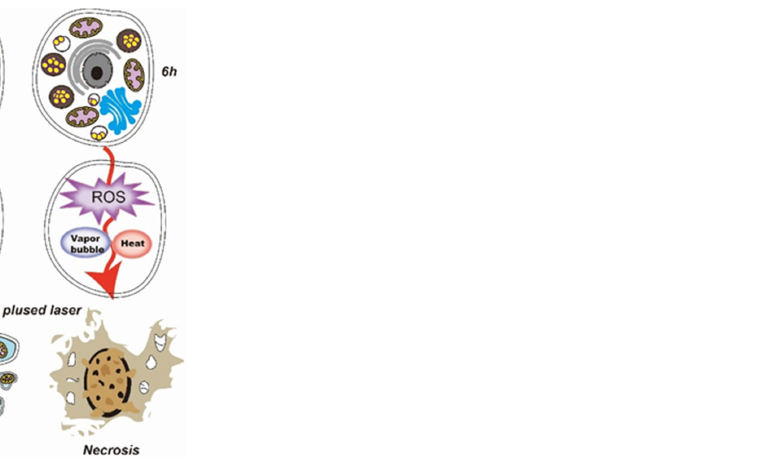
Figure 1. The effect of PEG-coated gold nanospheres (PEG-AuS) for phototherapy under nanosecond pulsed laser radiation. 2. Material and Methods 2.1. Cell Lines and Reagents The human moderately-differentiated gastric cancer cell line SGC-7901 purchased from the Cell Bank of the Academy of Military Medical Science (Beijing, China) and the human immortalized normal gastric mucosal cell line GES-1 obtained from the Beijing Institute of Cancer Research (Beijing, China) were donated by State Key Laboratory of Cancer Biology, the Digestion Department of XiJing Hospital. The SGC-7901 and GES-1 cells were cultured in RPMI1640 medium (HyClone) supplemented with 10% fetal bovine serum (HyClone) and 1% penicillin/streptomycina in a humidified incubator at 37 ° C with 5% CO 2 . Cetyltrimethylamonium bromide (CTAB) was purchased from Sigma (St. Louis, MO, USA). Sodium borohydride (NaBH 4 ), Chloroauric acid (HAucl 4 ) and Ascorbic acid (AA) were purchased from Aladdin. A Cell Counting kit (CCK-8) was purchased from DoJindo (Kumamoto, Japan). The trypan blue, Hoechst 33258, PI Staining Kits, DCFH-DA fluorescence probe were purchased from Beyotime Company (Shanghai, China). Singlet oxygen sensor green reagent (SOSGR) was purchased from Sigma. SH-PEG-NHS was purchased from local supplier. 2.2. Synthesis of PEG-AuS The AuS was synthesized according to the seed-mediated growth method. Briefly, 0.01 M HAucl 4 and 0.01 M cold NaBH 4 in 0.1 M CTAB was standing reacted for 2 h at room temperature to yield small nanoparticles as the seed solution in which particle sizes are less than 5 nm. Then, 0.01 M HAucl 4 and 0.1 M AA in 0.02 M CTAB was prepared as a growth solution. At last, 20 μ L of the seed solution was introduced into the 24 mL of the growth solution and standing reacted. About 20 nm AuSs were obtained after 12–16 h. To remove excess CTAB capped at the surface of AuS, centrifugation was undertaken twice